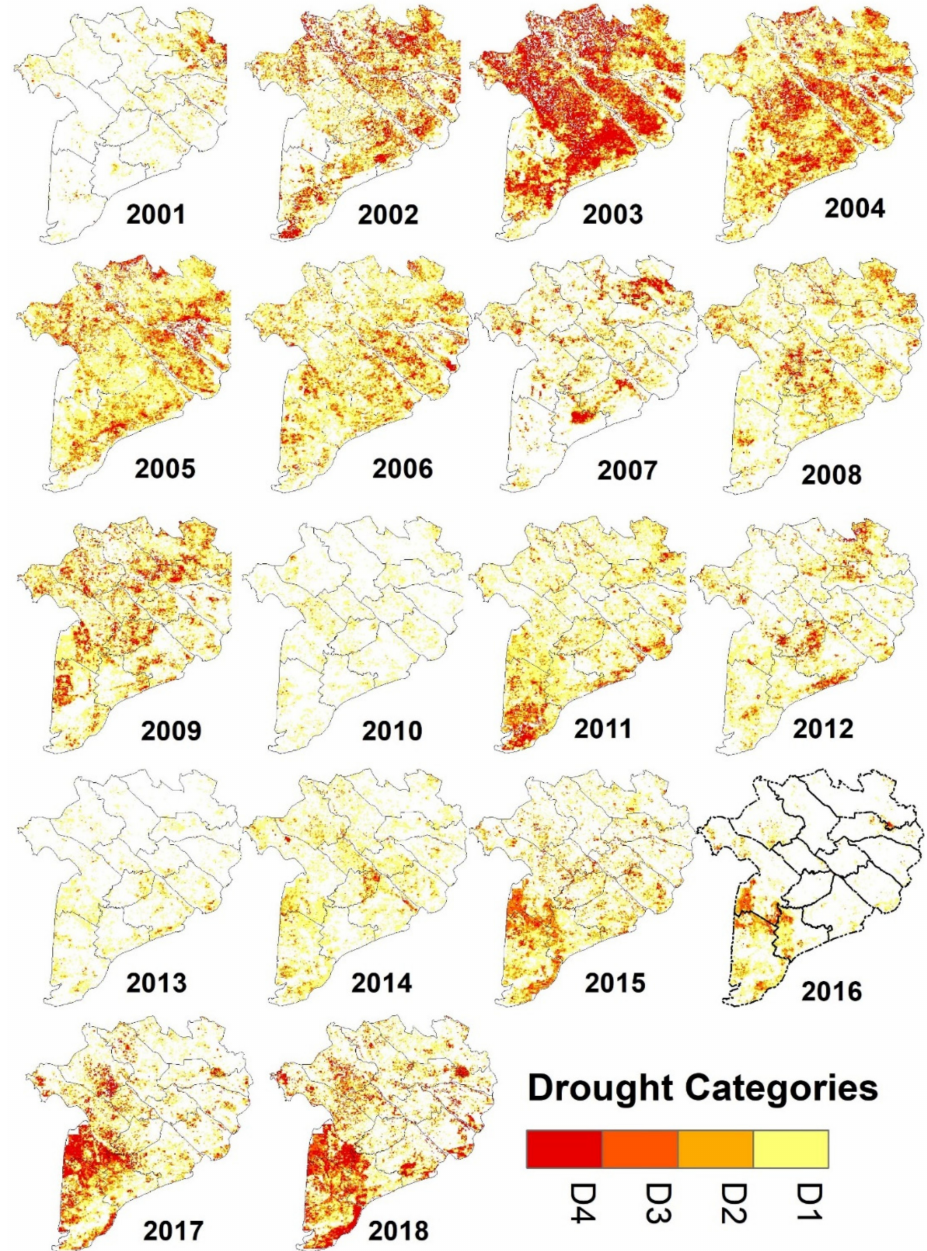
Figure 6. The spatiotemporal distribution of the annual drought